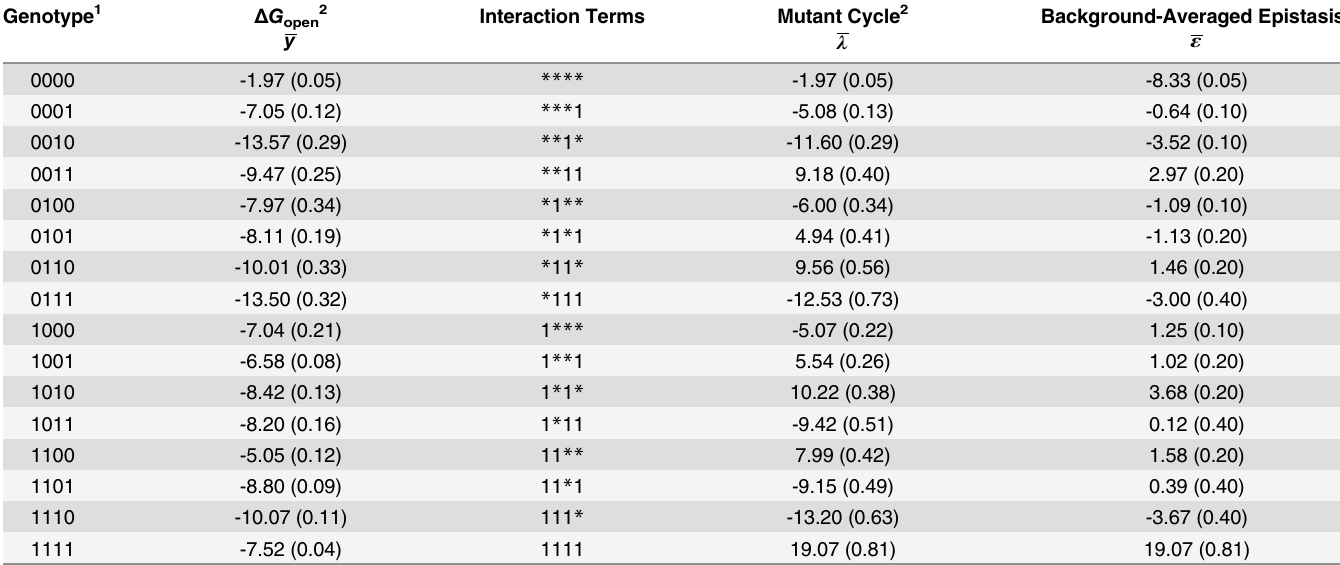
Table 2. Interaction terms based on the standard mutant cycle formalism ( l ) and on background-averaged epistasis ( ε ) for pore-opening free ener- gies in the Shaker K + voltage-gated channel. As for the PDZ domain (Table 1), background averaging modulates epistasis at each level given the exis- tence of higher-order terms. Primary data are from [60] and [61].